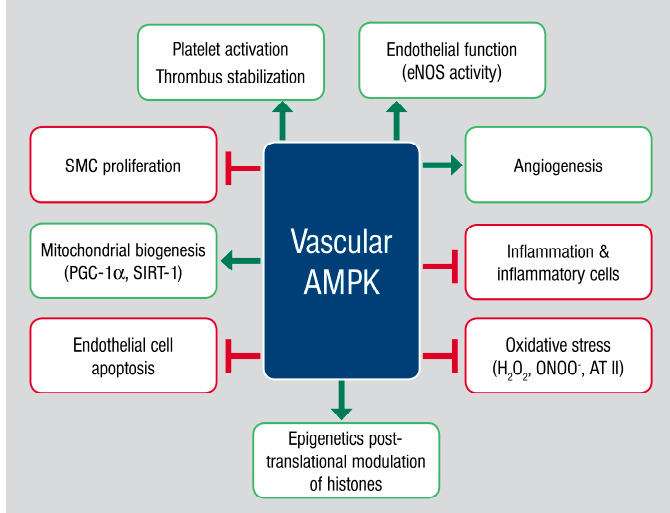
Figure 1. Physiological functions of the vascular adenosine monophosphate-activated protein kinase (AMPK). Activation of the vascular AMPK leads to enhanced platelet activation and thrombus stabilization, beneficial impact on the vascular function by eNOS phosphorylation and reduction of oxidative stress by controlling mitochondrial biogenesis and mitochondrial gene expression.